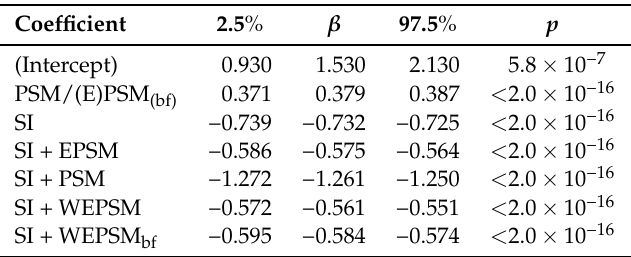
Table 5. GLMM (Generalised Linear Mixed Effects Model) estimates ( β ), 95% confidence intervals, and p -values of the fixed effects associated with subject-independent (SI) performance and personalisation–generalisation approaches.